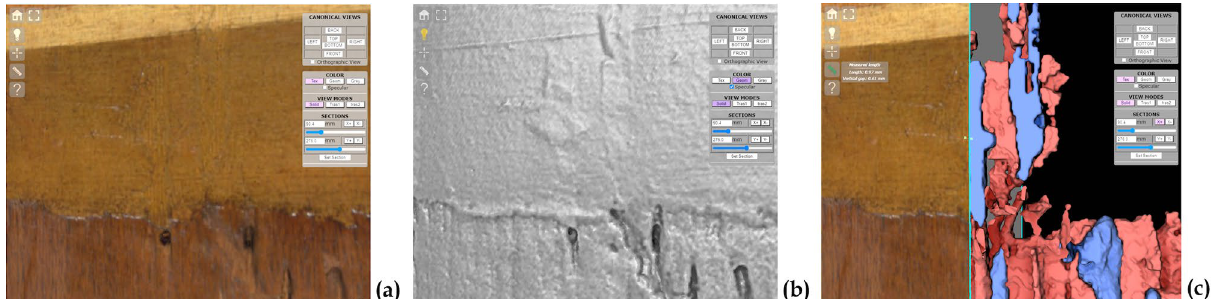
Figure 4. Exploring a previously restored area. ( a ) On the texture, the retouched areas are covered with typical hatching used by restorers. ( b ) A small bump is visible with the detail-enhancing illumination and simulated grazing light. ( c ) Just 0.6 mm below the surface, the collapsed holes that were filled during the past restoration are shown in results provides a virtual tour of the painting and its stratigraphic layering, from the choices of the materials for the preparatory layers to the fine technique used to create the bright and extremely naturalistic details.